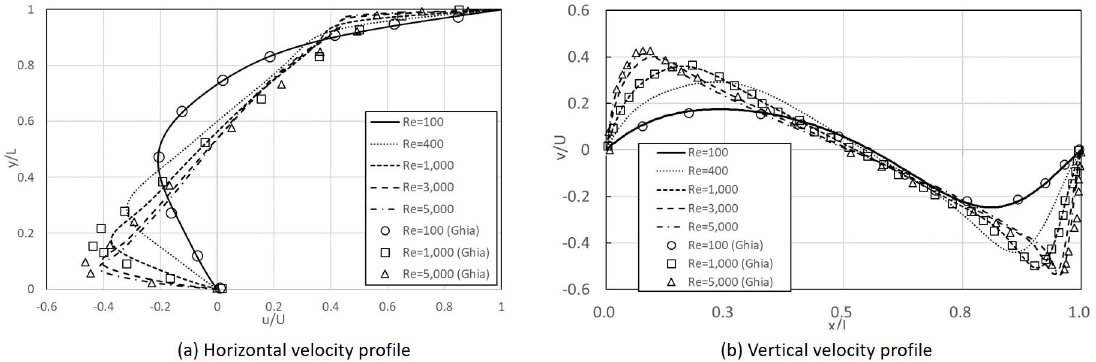
Figure 10. Vertical and horizontal velocity profiles for various Re